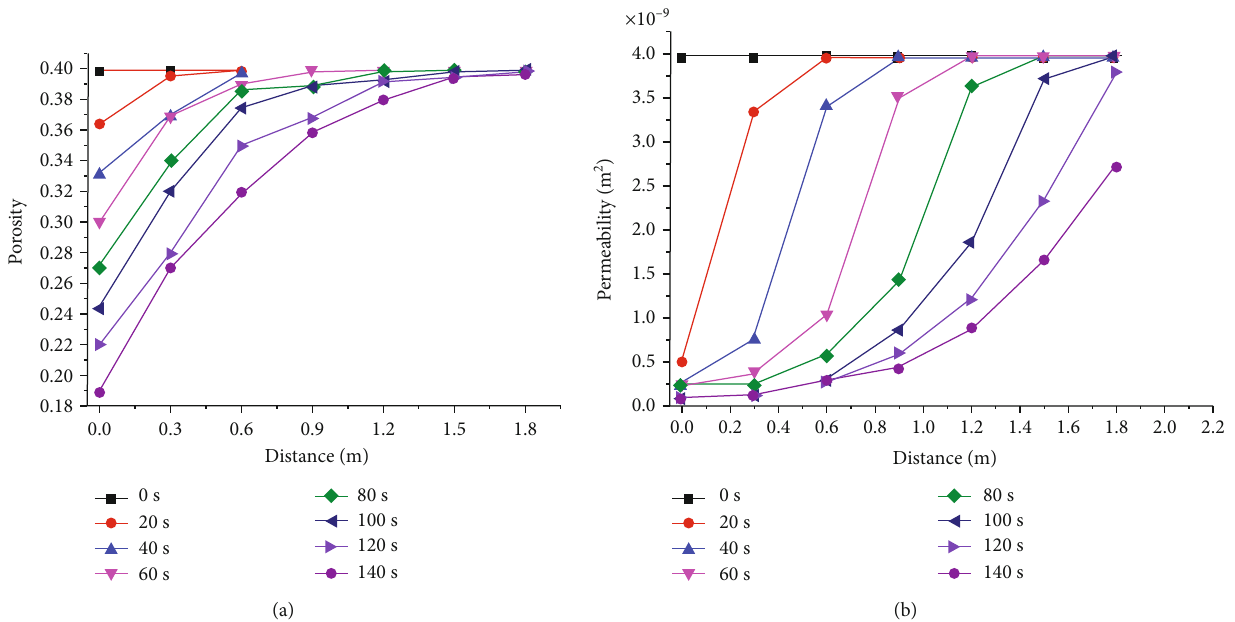
Figure 6: The temporal and spatial variation in porosity and permeability (a. the variation of porosity; b. the variation of